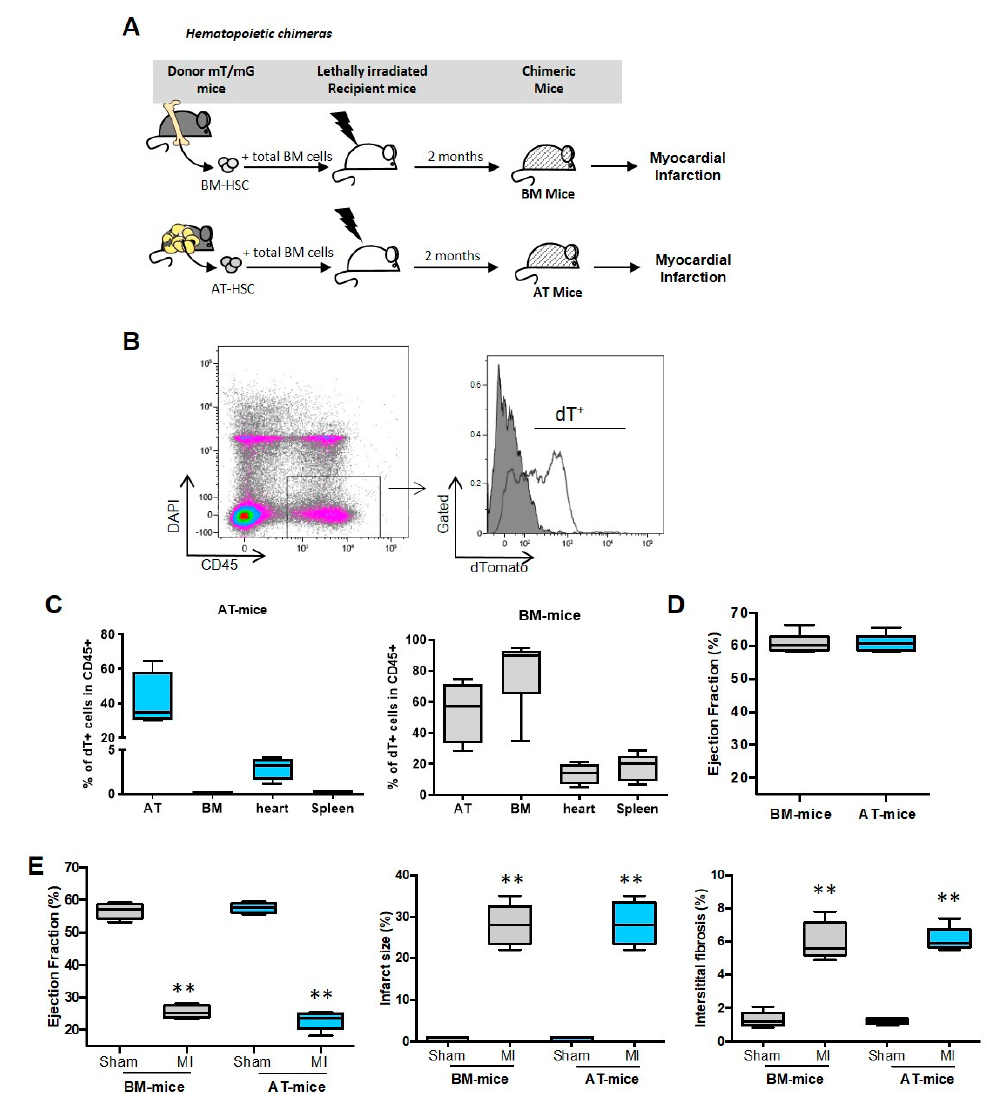
Figure 1. Establishment of chimeric mice models to reveal the distinct role of adipose tissue or bone marrow-derived inflammatory cells. ( A ) Hematopoietic chimera strategy: 2.10 3 hematopoietic stem cells (HSC) sorted from sub-cutaneous adipose tissue (AT) or bone marrow (BM) of mTmG mice were co-injected with 2.10 5 total BM cells from C57Bl6 mice into lethally irradiated C57Bl6 recipients. Eight weeks after hematopoietic reconstitution, chimeric mice were subjected to myocardial infarction. ( B ) Representative dot plots of flow cytometry analyses showing the chimerism (tdT + cells among CD45 + cells; open histogram) or wild type cells (dT - ; grey histogram) in the AT of AT- chimeric mice (n = 4). ( C ) Quantification of the chimerism in sub-cutaneous AT, BM, heart and spleen of AT- and BM-chimeric mice (n = 4–6). ( D ) Ejection Fraction in unoperated AT- and BM chimeric mice (n = 8). ( E ) Quantification of ejection fraction, infarct size and interstitial fibrosis in sham and infarcted chimeric mice (n = 5). Comparisons between 2 group were performed using Dunn’s multiple comparisons test. ** p <